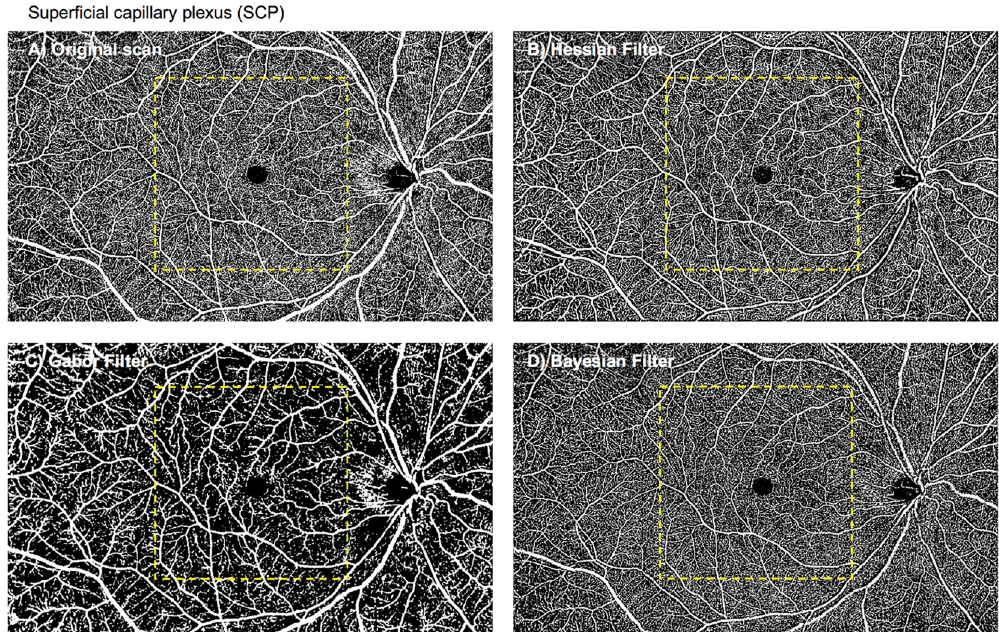
Figure 2. Superficial capillary plexus: original scan ( A ) and enhanced with various filters ( B – D ). Perfusion densities were investigated in 2 different regions of the superficial capillary plexus: (1) the macular region (within yellow dotted box) with a 6 × 6-mm 2 region centred over the fovea and (2) the peripheral region (outside the yellow dotted